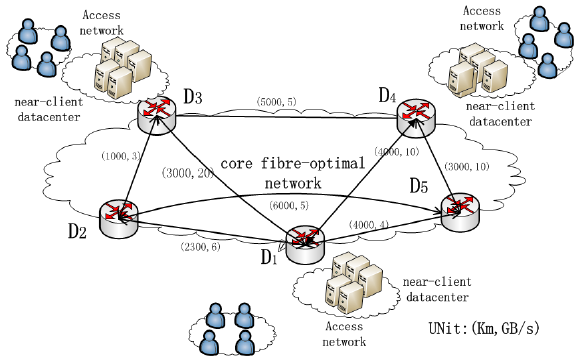
Fig. 1. The network environment of multimedia cloud data